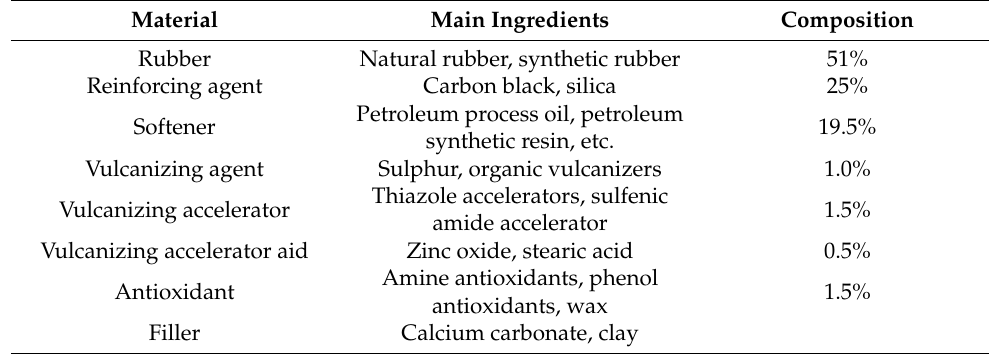
Table 3. Basic composition of reclaimed rubber particles